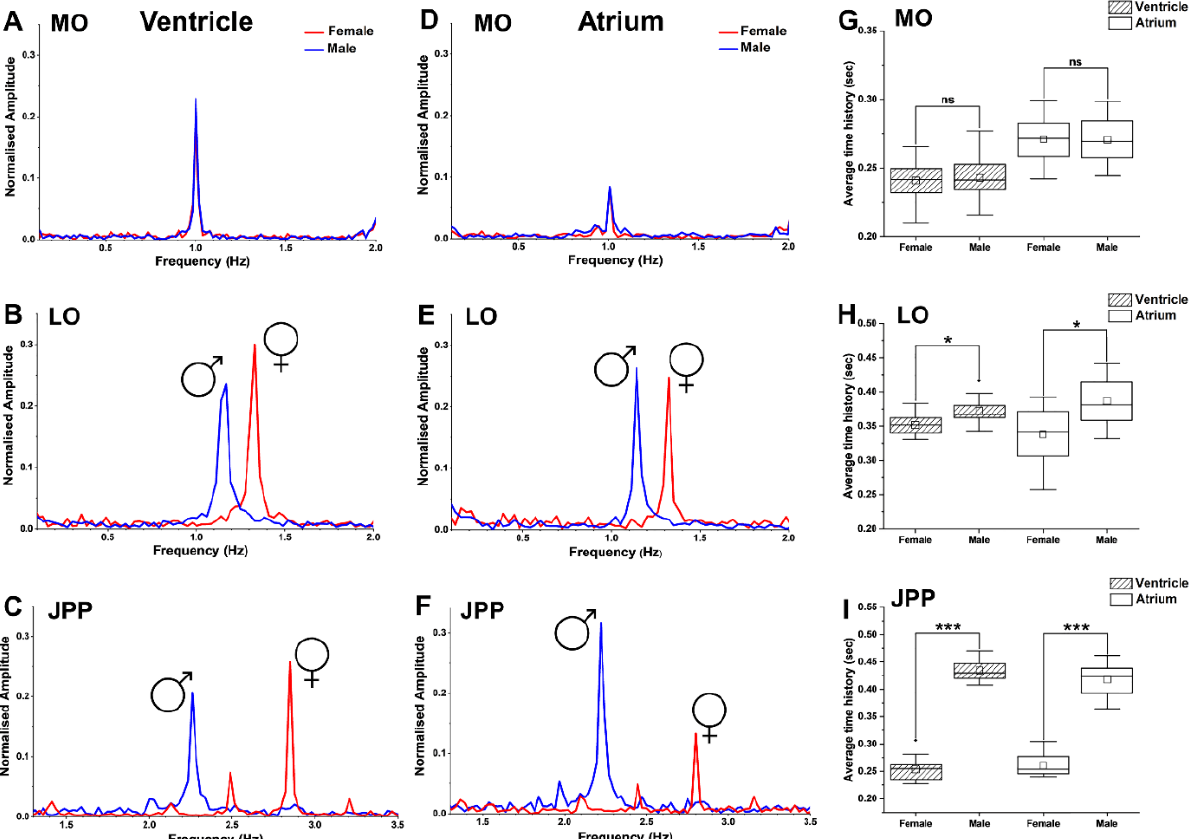
Figure 10. Graphs showing cardiac frequency (F D ) analysis of genetic male and female G. holbrooki embryos at three developmental stages. Plots ( A – C ) represent ventricular F D of the female/male at MO, LO, and JPP stages, while ( D – F ) represent those of atrium at the corresponding stages, respectively. Box plots ( G – I ) illustrate the average time history (s) differences between ventricle and atrium contractions in male and female embryos at MO, LO, and JPP stages, respectively. Box plot data are presented as means ± SD (n = 10 /developmental stage/sex). Small square and a horizontal line on each box plot indicate mean and median values, respectively. ns = non-significant. * p < 0.05 and *** p < 0.001.